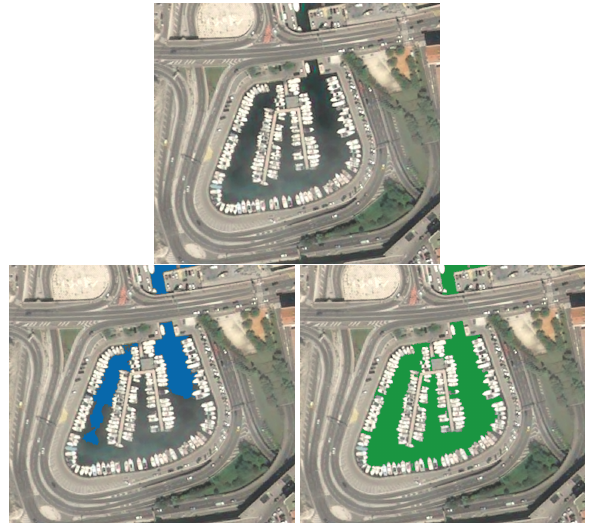
Figure 3. Example of a water segmentation before and after the automatic correction. Pl´eaides image over Marseille, France. Water prediction, water prediction after combining with an external source. Figure 5. Vector layers of building, tree, water, and road polygons on top of the orthoimage (left) with a crop (right). Red: rooftops, green: trees, blue: water, violet: